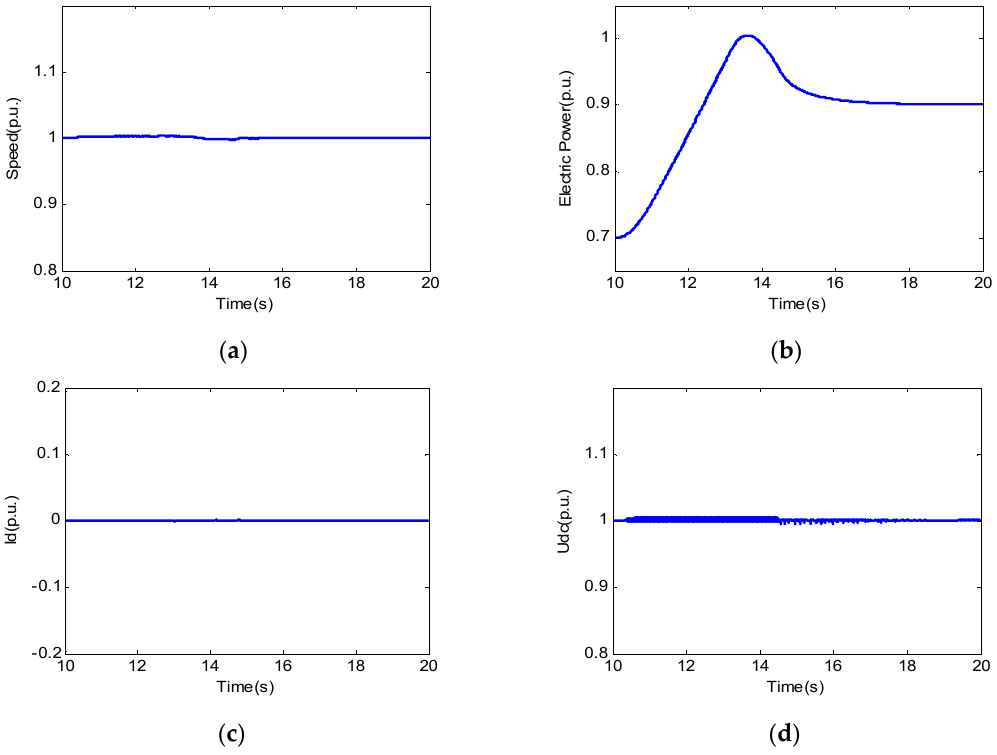
Figure 10. Simulation results with optimized parameters: ( a ) Speed; ( b ) electric power; ( c ) current of d-axis; ( d ) DC voltage.